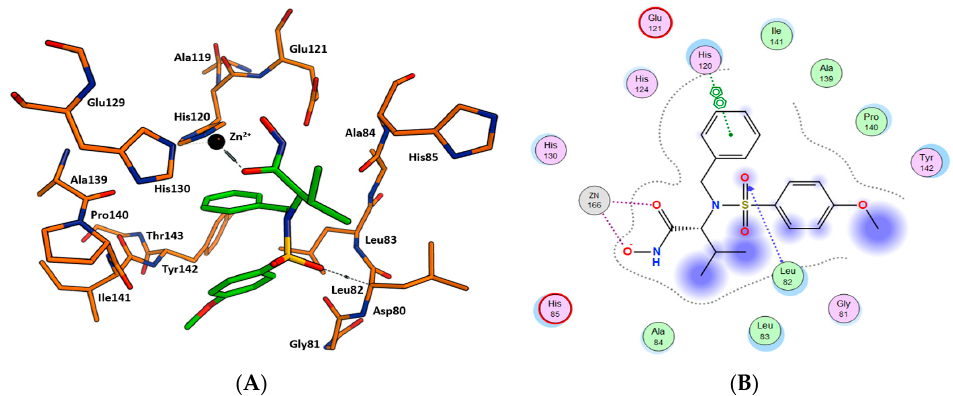
Figure 3. ( A ) Modeled complex of hydroxamate 20 bound to the MMP-2 active site (PDB accession code: 1HOV). ( B ) Ligand interaction map of 20 generated using MOE. Regions surrounded by a blue cloud indicate solvent-exposed portions of the ligand.